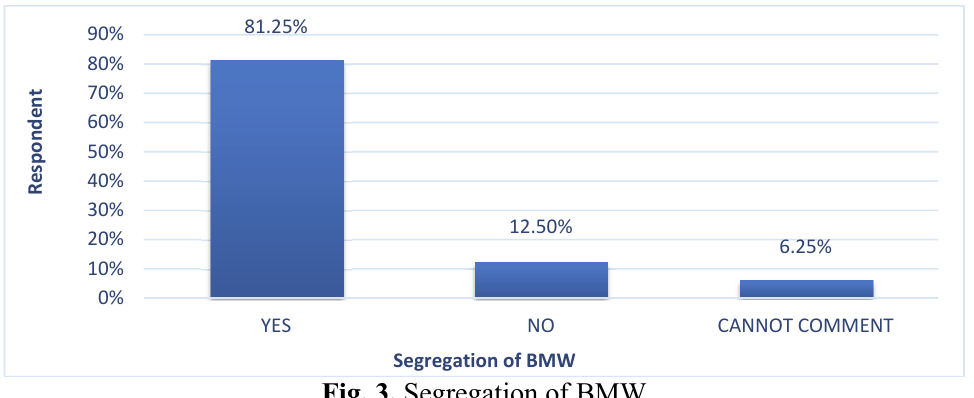
Fig. 3. Segregation of BMW